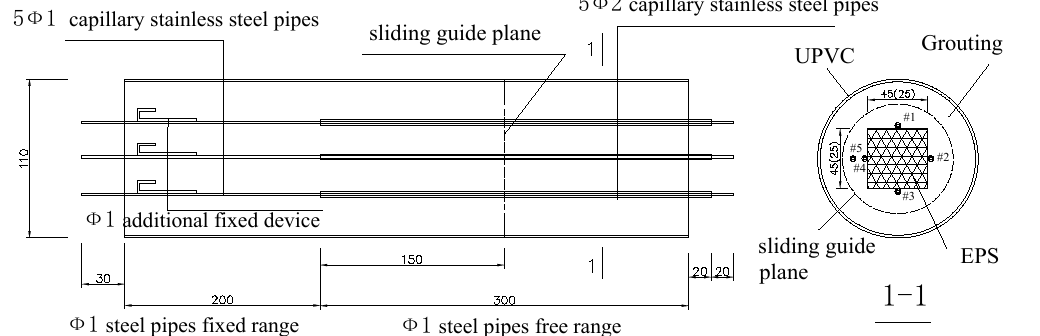
Figure 5. Single shearing test model (unit: mm).